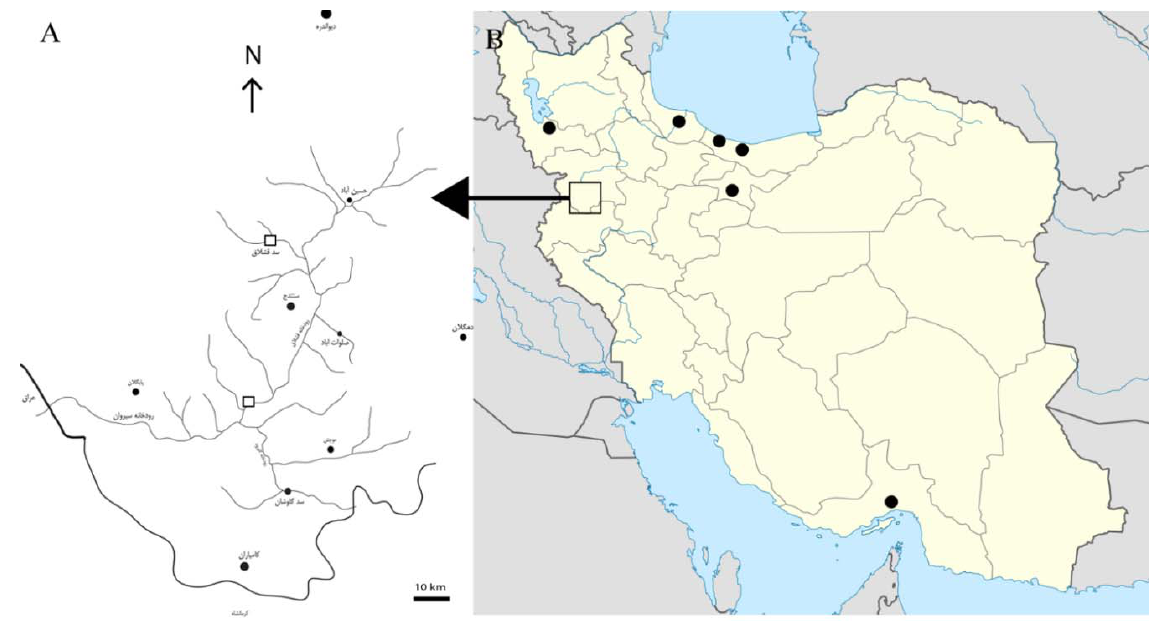
F IGURE 1. A. The map of Gheshlagh basin in the vecinity of Sanandaj city, the blank squres show the sampling stations. B. The location of sampling in the western Iran. The filled circles show the places from where Clinostomum complanatum has been